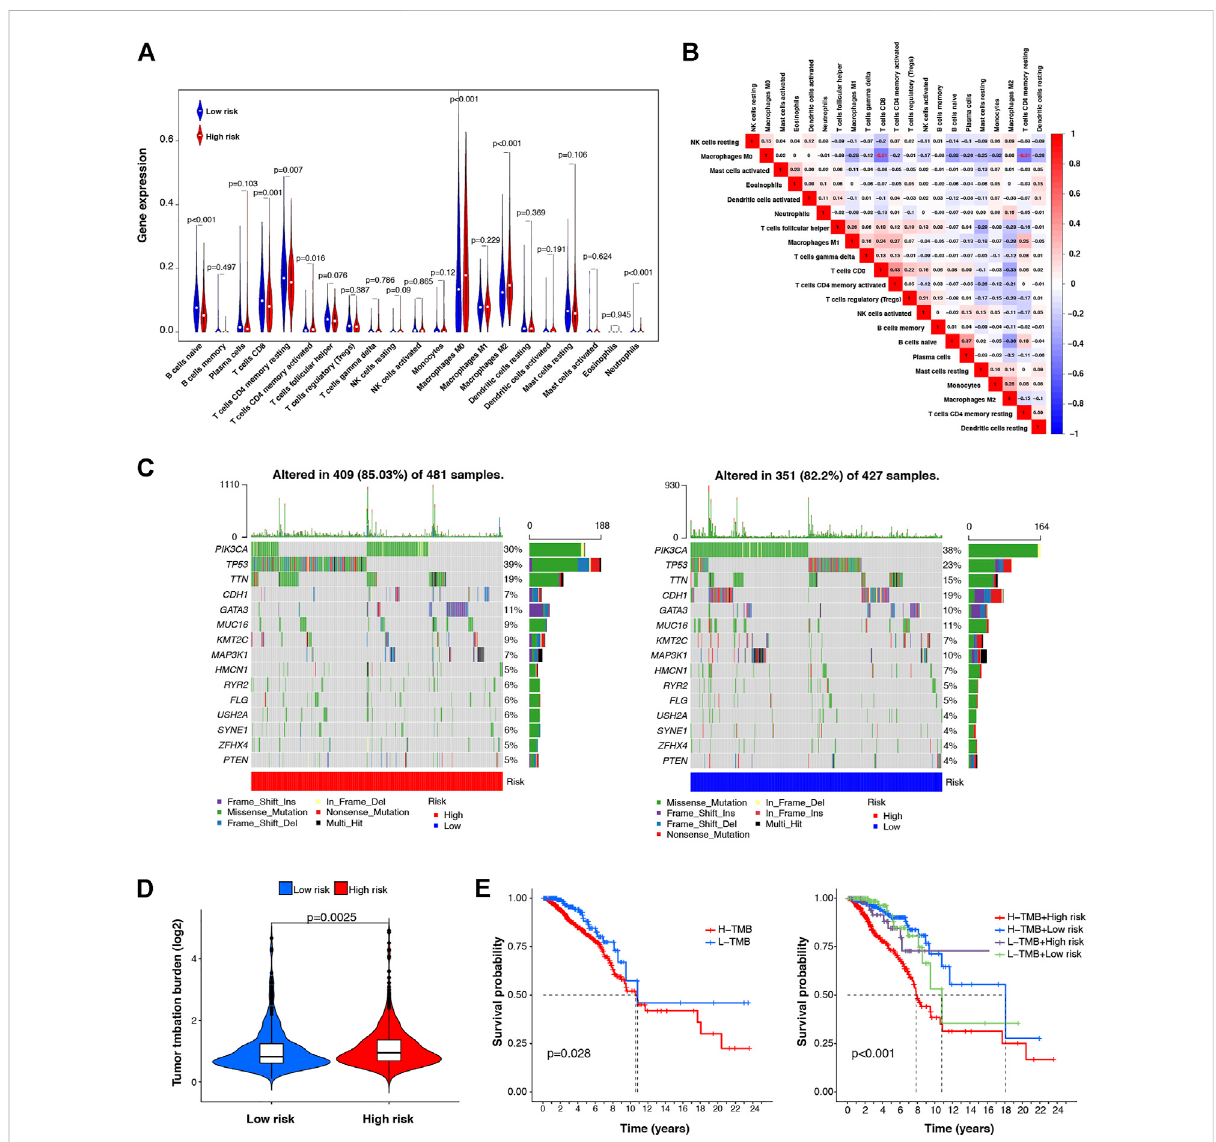
FIGURE 7 Correlation between the m7G-LPS and in fi ltrating level of immune cells and TMB. (A) Violin plots of the in fi ltrating level of 21 types of tumor- in fi ltrating immune cells between high- and low-risk groups. (B) Spearman correlation analysis of 21 types of tumor-in fi ltrating immune cells. (C) TMB analysis inlow- and high-risk groups. (D) Differenceanalysis ofTMB between low- and high-risk group (E) Kaplan – Meiercurveanalysis ofOS is shown for patients classi fi ed according to the TMB and risk